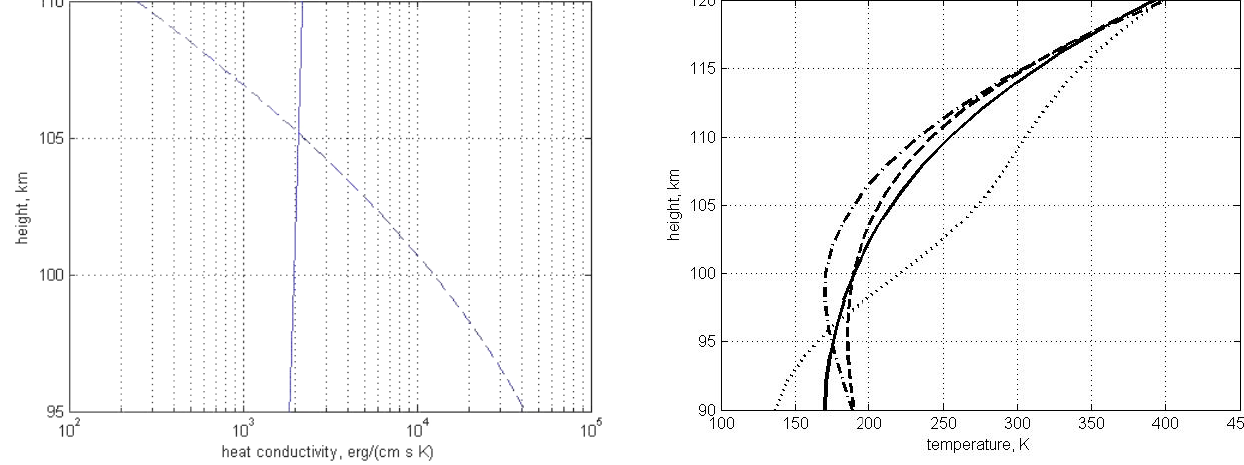
Fig. 7a. Height distributions of the thermal conductivity (solid curve) and eddy heat conductivity (dashed curve) with the eddy heat transport coefficient equaled to K ed , shown in Fig. 4. Eddy heat conductivity is given by the formula λ ed = K ec C p ρ erg(cmsK) − 1 , and the thermal heat conductivity is given by the formula λ th = 38 . 2 T 0 . 69 + 1 . 9 T + 51 . 4erg(cmsK) − 1 (Banks and Kockarts, 1973).